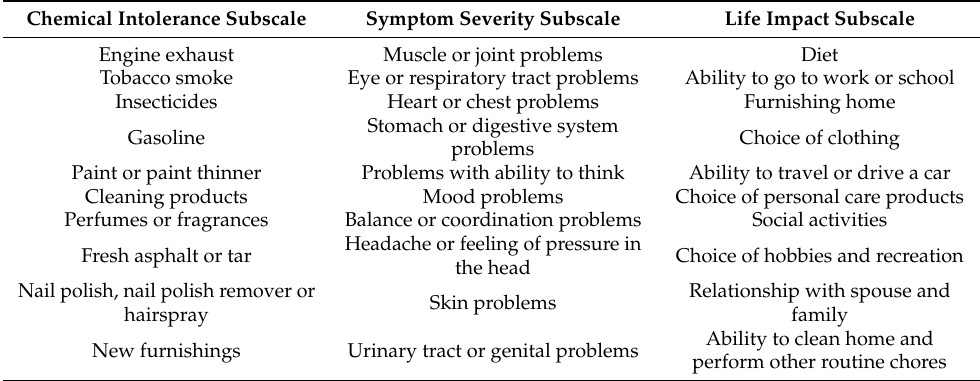
Table 1. QEESI© questionnaire subscales used to assess possible MCS and the assessed items within each